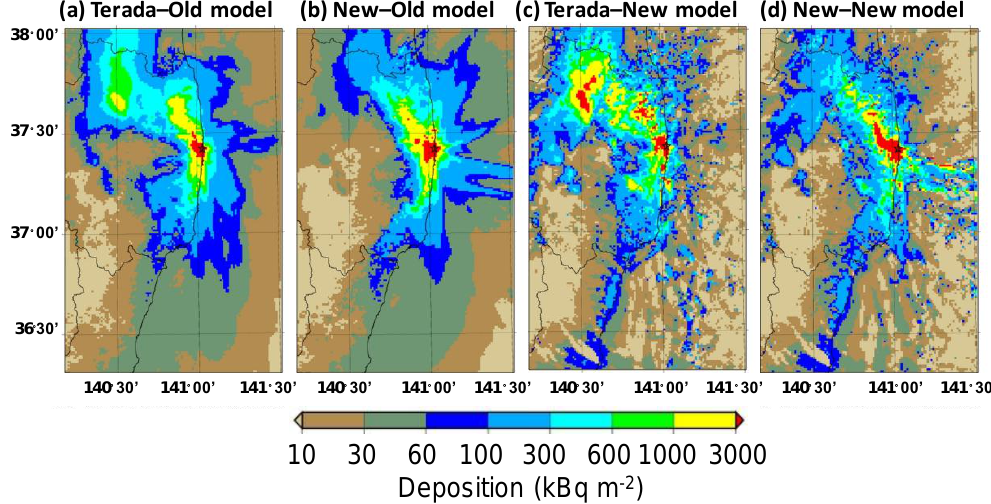
Figure 14. Local-scale spatial distributions of surface deposition of 137 Cs (Domain 3) in the four simulations using original and modified WSPEEDI-II (referred as “Old model” and “New model”, respectively) and Terada at al. (2012) and the new source terms (referred as “Terada” and “New”, respectively) at 00:00 on 1 April 2011.